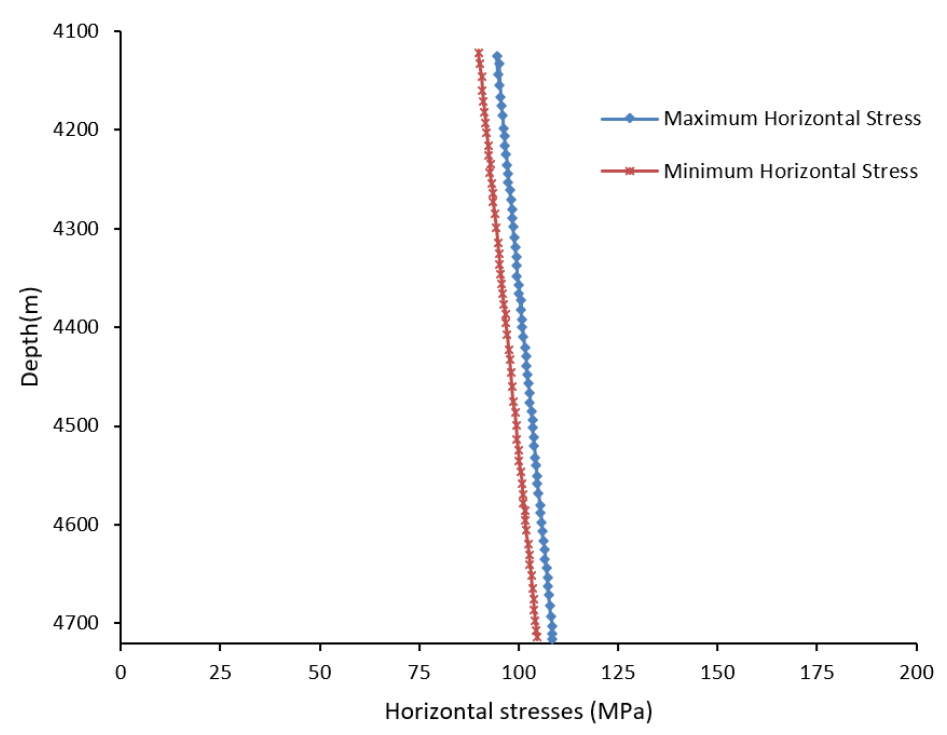
Figure 13. Minimum and maximum horizontal stresses vs. the depth of wellbore-D in the Azar oilfield. Furthermore, Eaton’s equation was applied to determine the amount of pore pressure